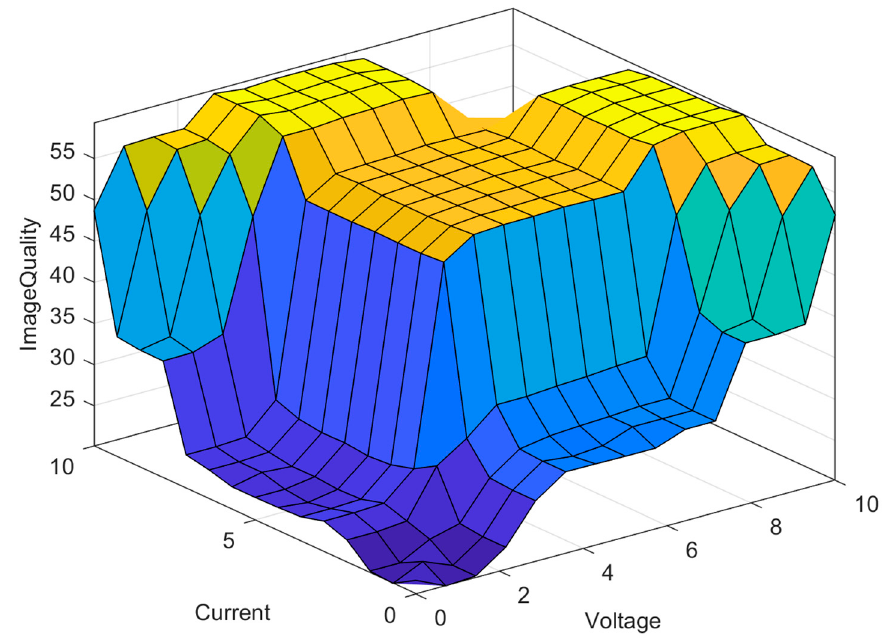
Figure 12. 3-D view of the model surface with respect to current intensity and voltage.